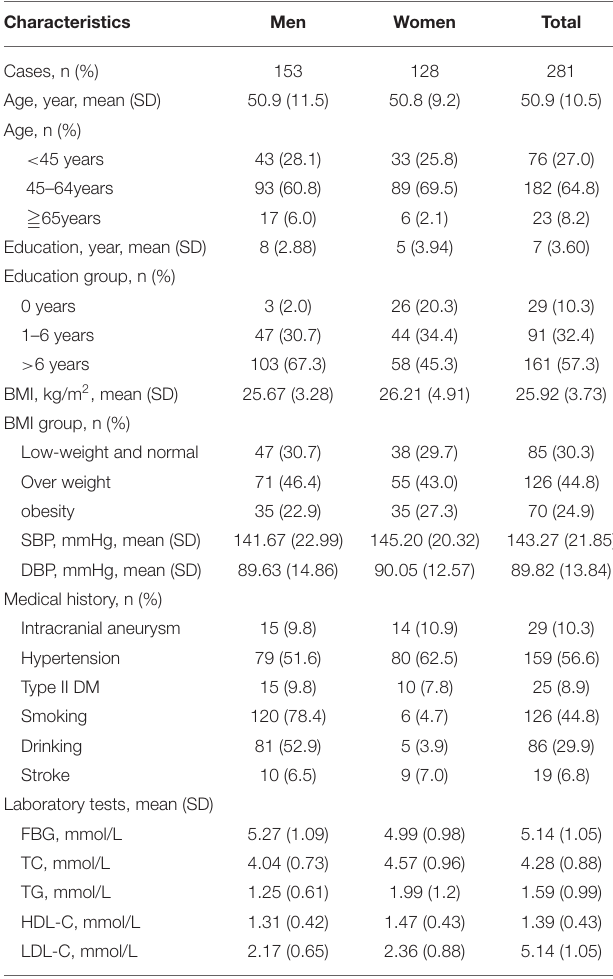
TABLE 1 | Demographical and clinical features among people with family history of